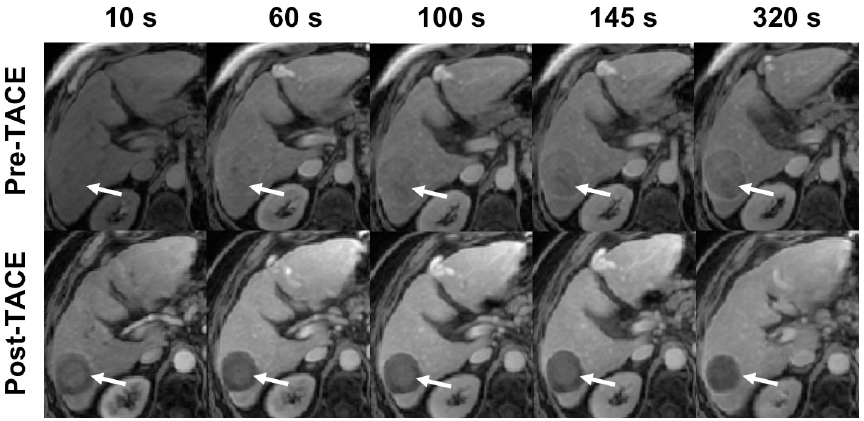
Fig 1. Example of a dynamic contrast-enhanced (DCE) MRI sequence for assessment of HCC enhancement. The first row presents the pre-TACE examination, while the second row presents the post-TACE examination. The white arrow indicates the location of the HCC across the arterial phases before and after